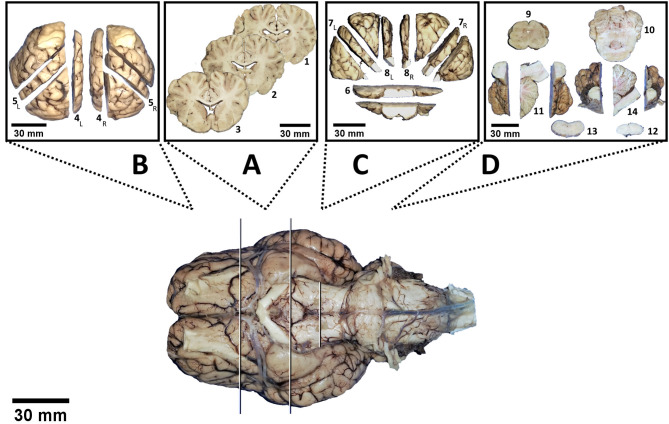
Virtual division of the brain into 4 blocks (white and black lines). Following dissection according to the protocol, each block delivers a certain amount of slabs depicted in a separate box: No. 1 to 3 out of block (A), No. 4 to 5 out of block (B), No. 6 to 8 out of block (C) and No. 9 to 14 out of block (D). Subscript letters indicate distinctions between left (L) and right (R) hemispheres.